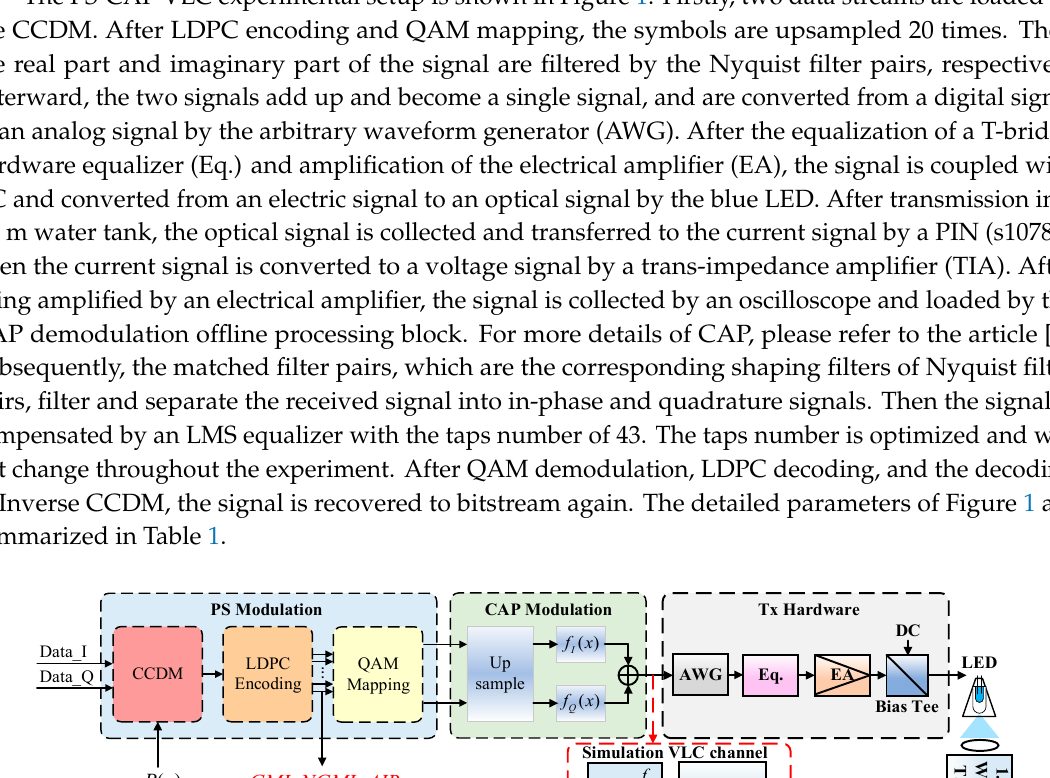
Table 1. Detailed parameters of experimental and simulation setup.